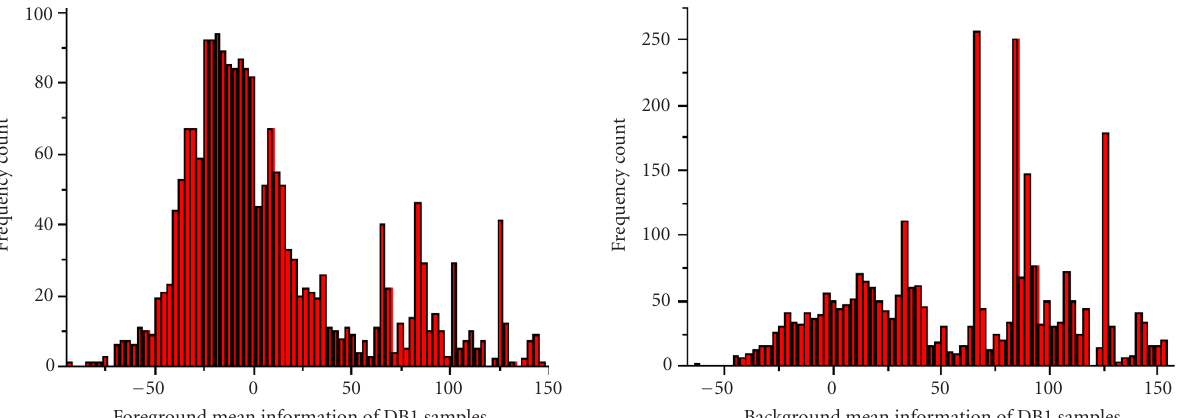
Figure 12: The block mean information MeanI of the samples. The horizontal coordinate represents the value of the block mean information while the vertical coordinate represents the frequency count of the